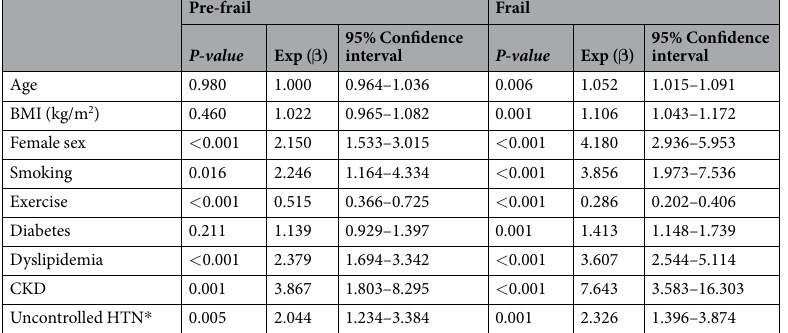
Table 4. Multiple logistic regression analysis: factors associated with frailty status. BMI: body mass index, CKD: chronic kidney disease, Dyslipidemia: either hypercholesterolemia, hypertriglyceridemia, low HDL-cholesterolemia, or a combination. (Hypercholesterolemia: 12 h-fasting total cholesterol ≥ 6.22 mmol/L (240 mg/dL) or taking hypercholesterolemia medications,